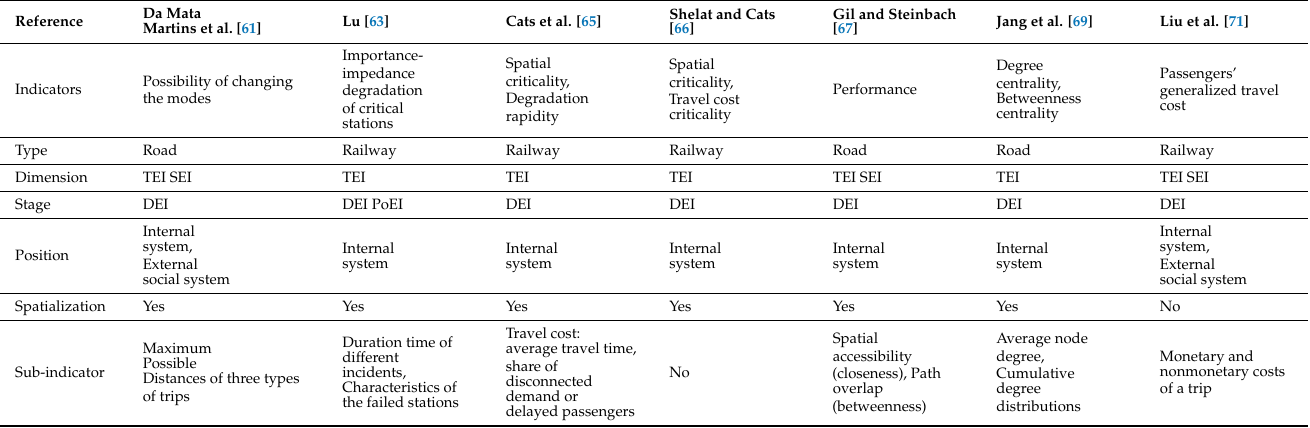
Table 4. Summary of the seven selected